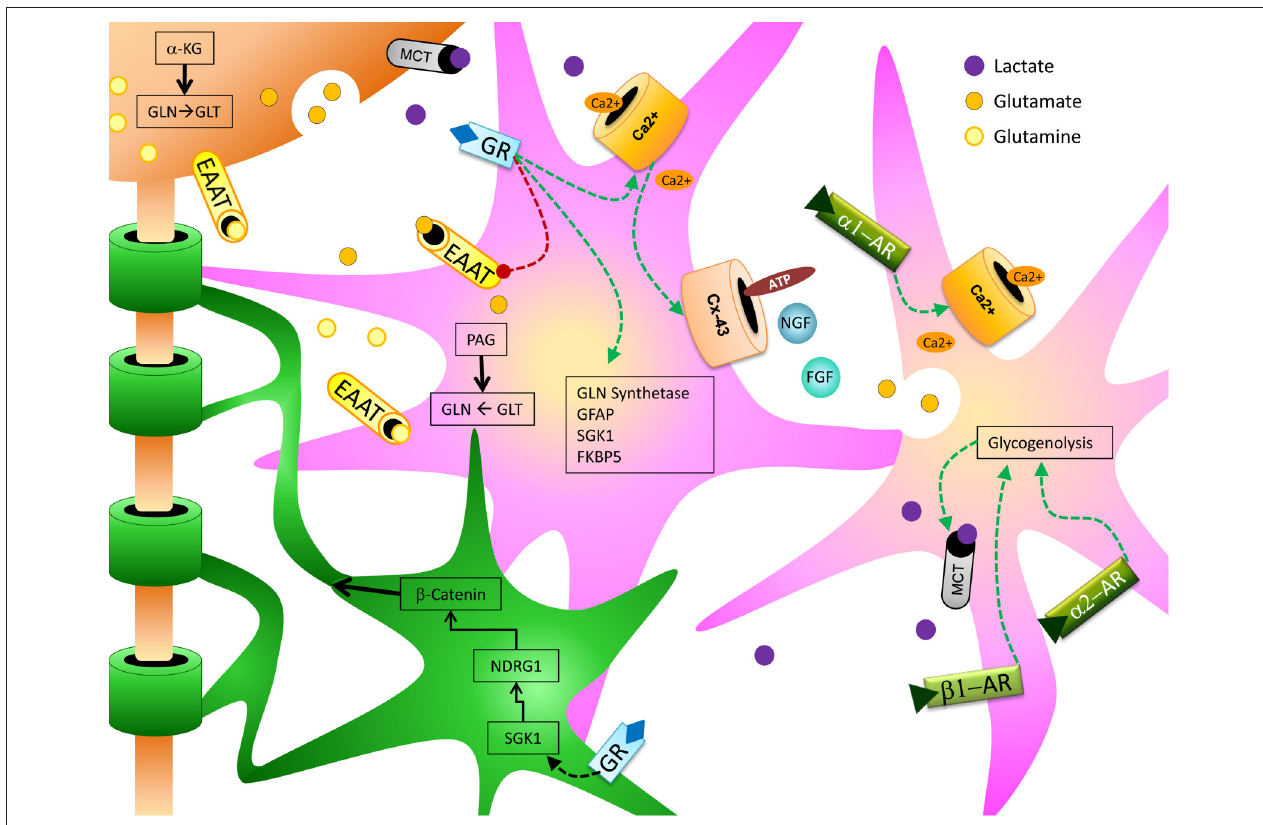
FIGURE 1 | Depicts the relationship between stress hormone effects on astrocytes (pink) and oligodendrocytes (green) and how they can support and enhance neuronal (orange) function to produce cognitive enhancing